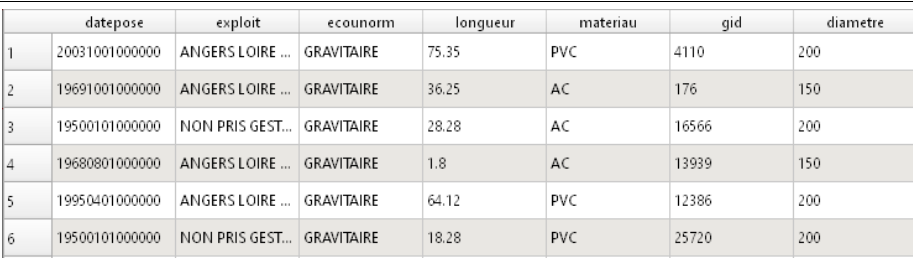
Figure 2. Example of an attribute table: Angers Metropolis in France.